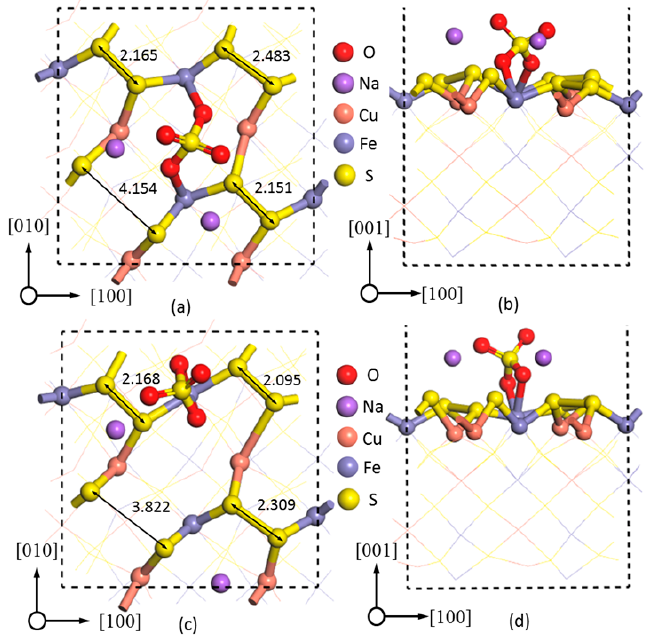
Figure 7. The most stable configuration of Na 2 SO 4 adsorbed on the (001)-S chalcopyrite surface: ( a ) top view and ( b ) side view in -BB mode; ( c ) top view and ( d ) side view in -BM mode. Distances are in angstroms.